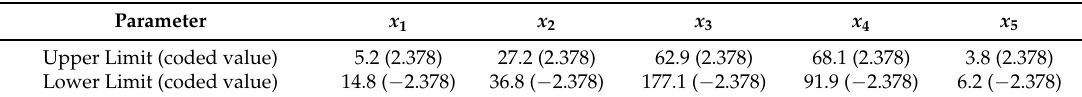
Table 5. HGA variable coding for the biotechnology case